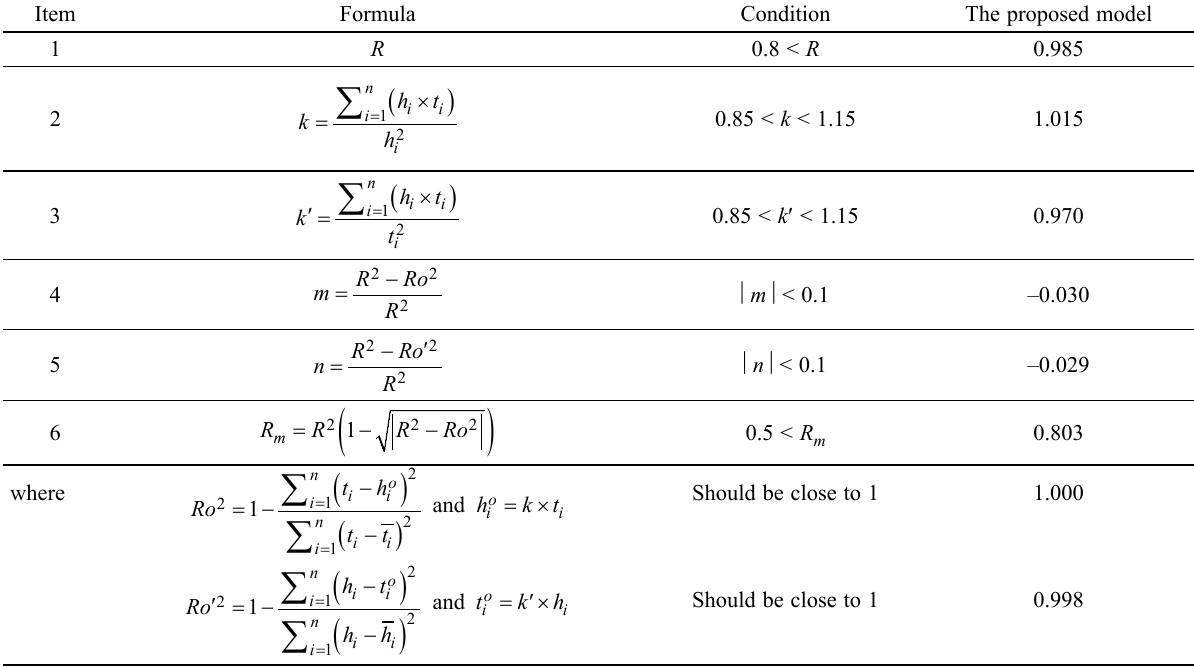
Table 3. Statistical parameters of the LGP model for the external validation Item Formula Condition The proposed